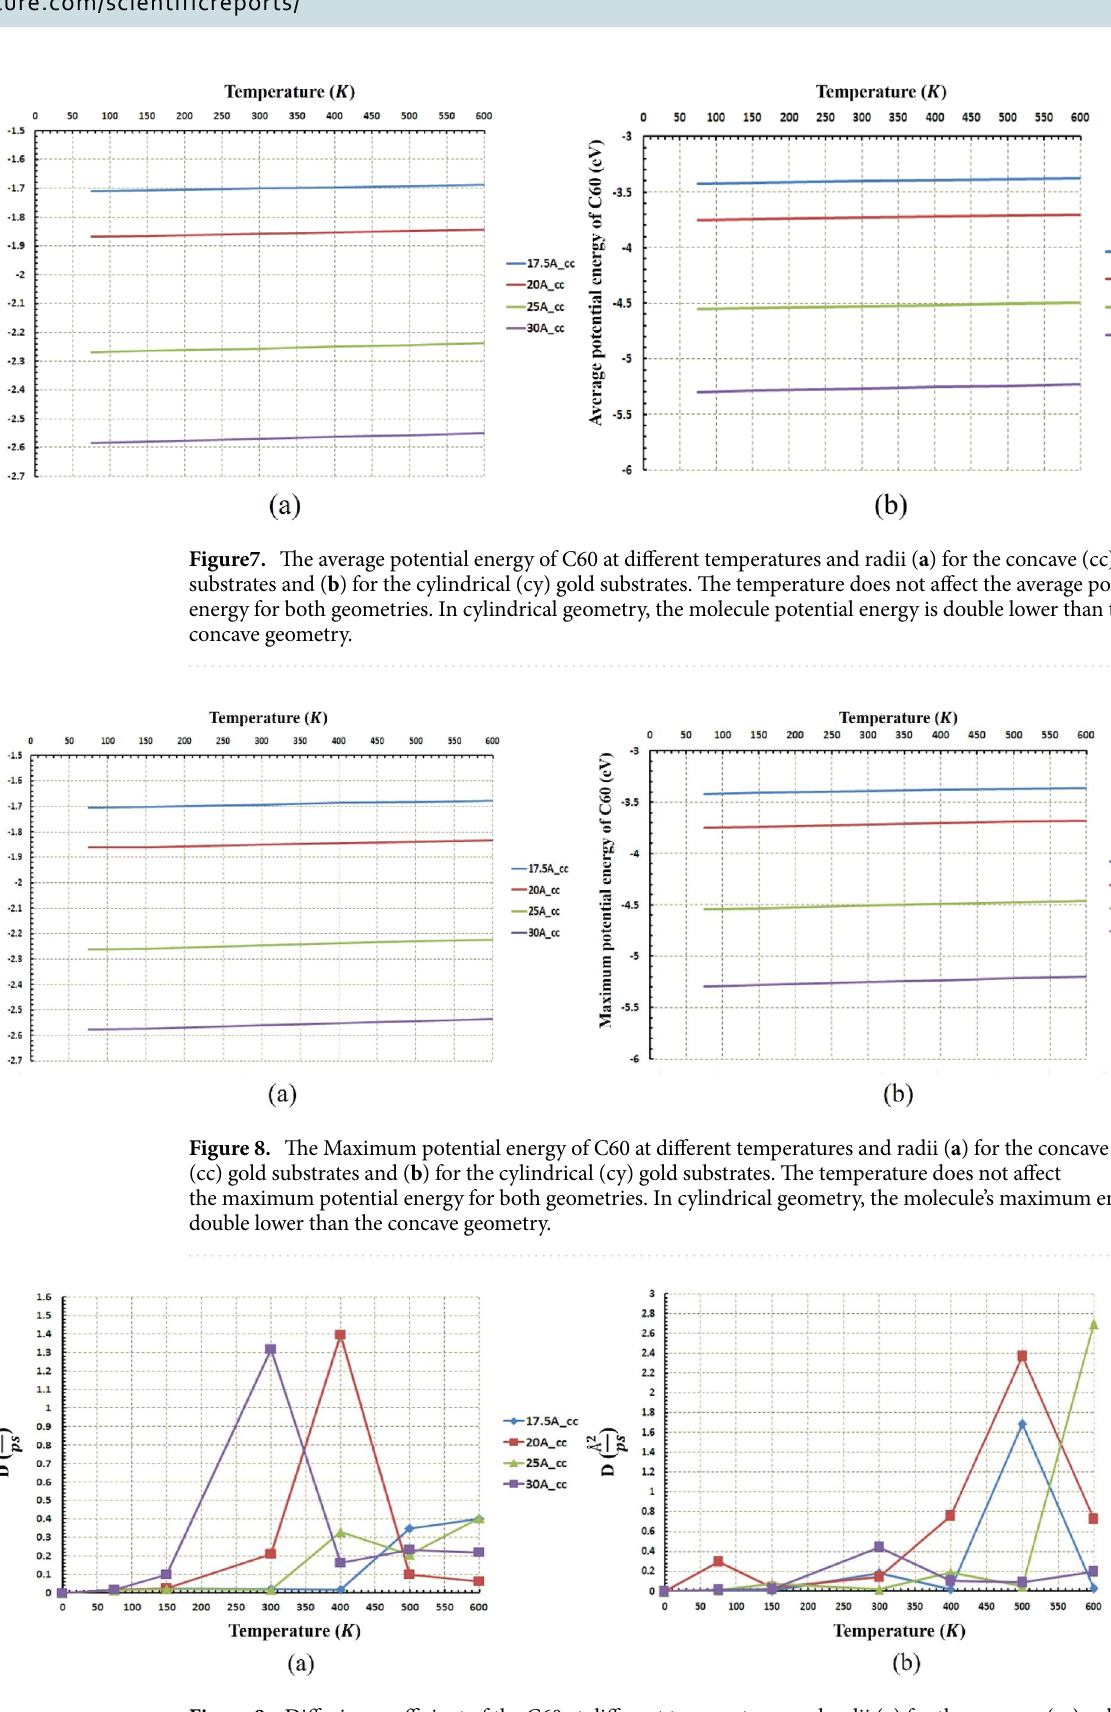
Figure 9. Diffusion coefficient of the C60 at different temperatures and radii ( a ) for the concave (cc) gold substrates and ( b ) for the cylindrical (cy) gold substrates. The diffusion coefficient at almost all radii in both 2 ) . That is the main reason for the long-range movement of geometries is higher than 0.01 ( Å ps